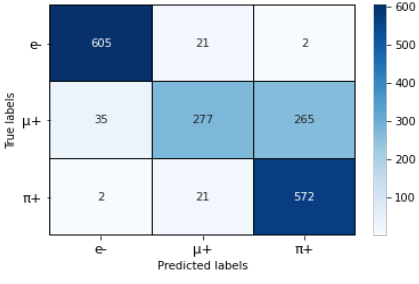
Table 2. Performance on neutral particles classification.